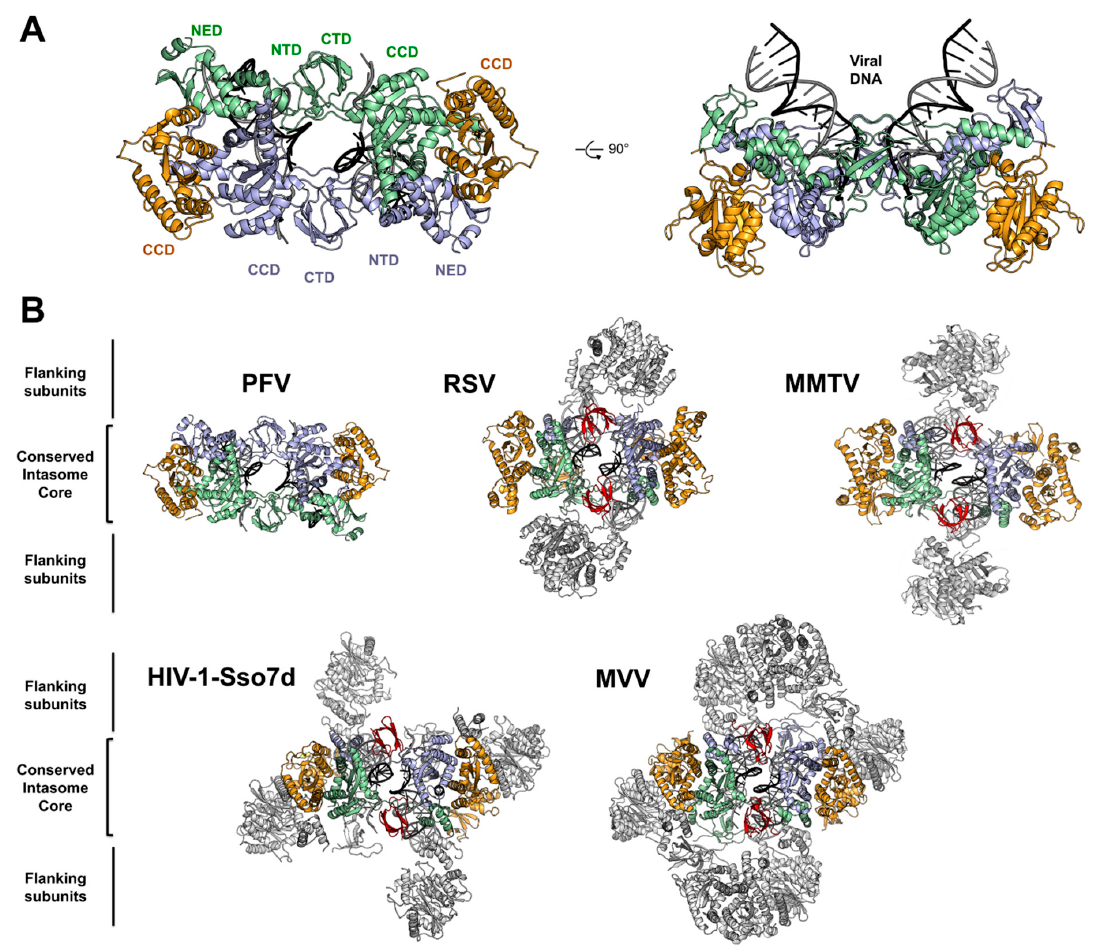
Figure 3. Architecture of PFV and related retroviral intasomes. ( A ) PFV intasome shown in two orthogonal views (PDB 4E7H) with individual domains indicated. Inner IN subunits are colored pale green and light blue, and the outer subunits are in orange. ( B ) Comparison of retroviral intasomes structures (RSV PDB: 5EJK, MMTV PDB: 3JCA, MVV PDB: 5M0Q). Complexes are viewed from below the active site. The conserved intasome core, CIC, is colored as in (A), synaptic CTDs are in red, and flanking subunits are in light grey.